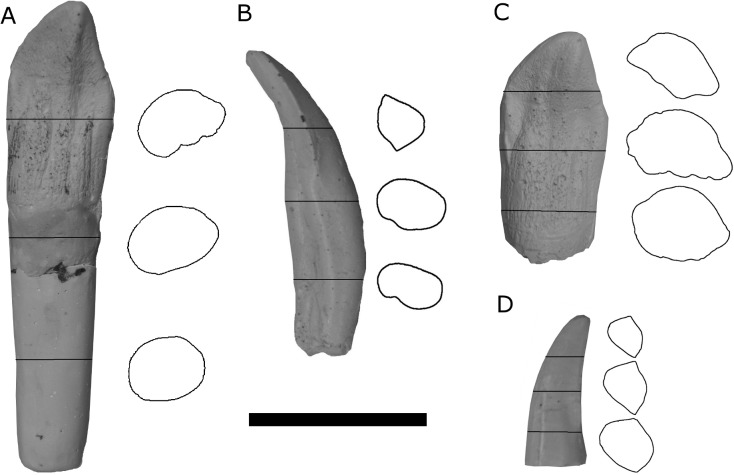
Photographs and cross-sectional outlines of cast specimens used in the flume experiment.(A) Root-bearing Camarasaurus tooth (UWO-VPC-2013.003), (B) Root-bearing Allosaurus tooth (UWO-VPC-2013.001), (C) Shed Camarasaurus tooth (UWO-VPC-2013.004), and (D) Shed Allosaurus tooth (UWO-VPC-2013.002). Scale bar = 5 cm.